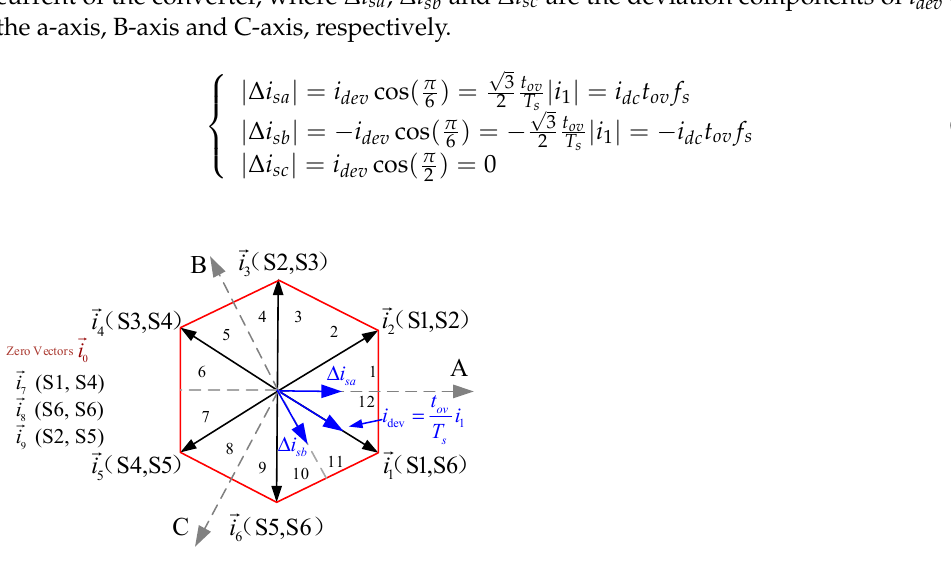
Figure 6. Mapping of the current deviation i dev of i 1 .